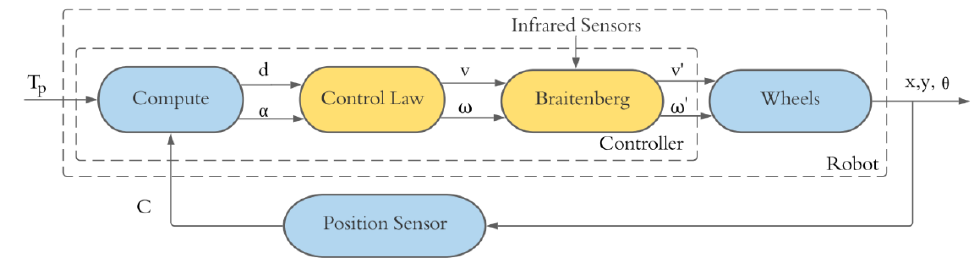
Figure 4. Diagram of the position control problem with the Braitenberg algorithm [46].